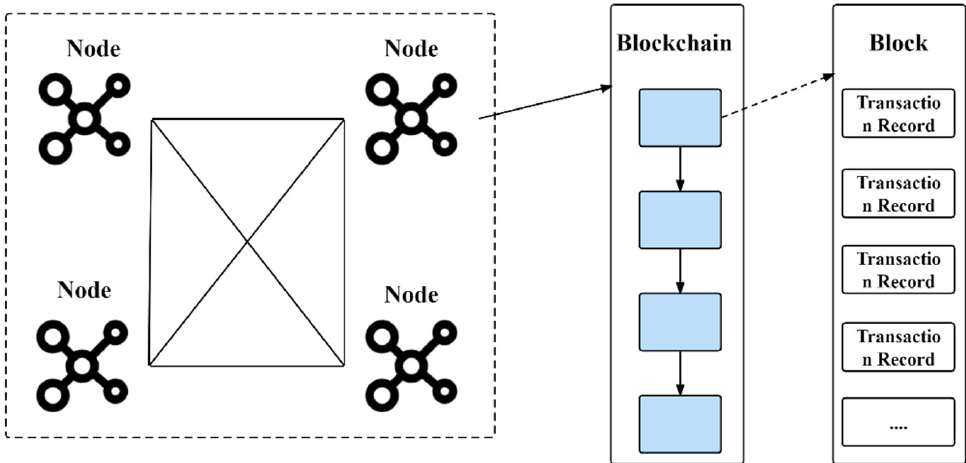
Figure 1. The composition of the blockchain.